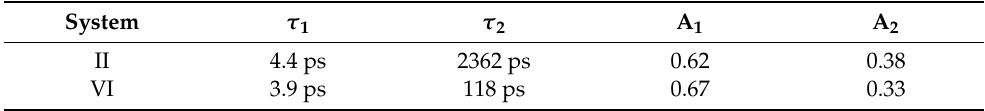
Table 2. HB Lifetime values and relative population weights (A 1 and A 2 ) obtained fitting the HB autocorrelation functions by Equation